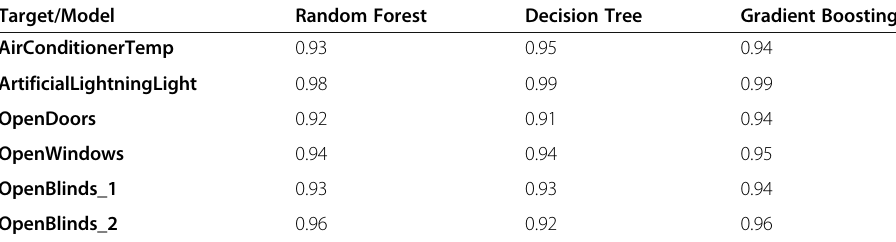
Table 3 Target precision of the trained classification models Target/Model